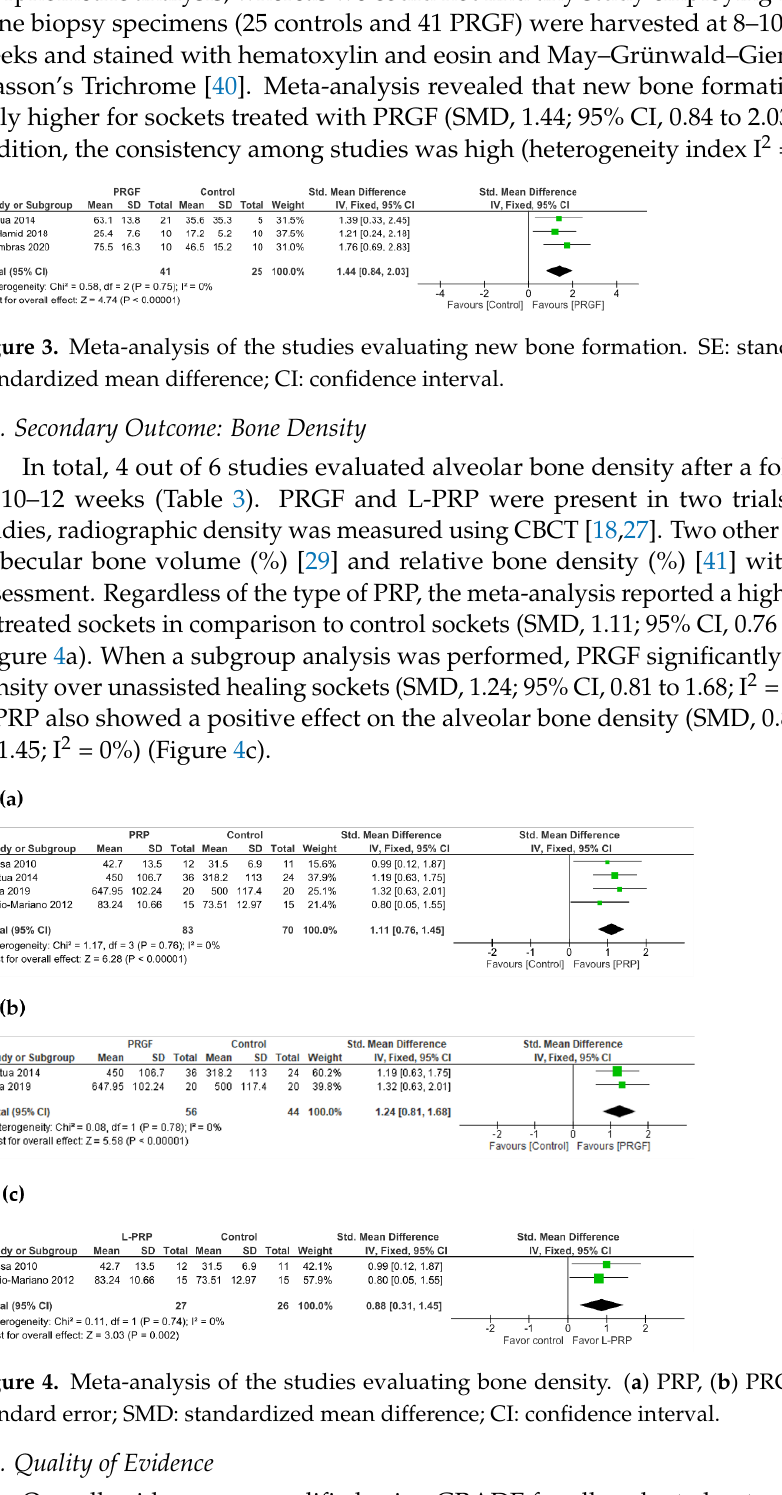
Figure 2. Study selection flow diagram. PRISMA flow diagram of the screening and selection pro- cess. Quality assessment of the included RCTs. ( a ) Risk of bias summary: review authors’ judgments about each risk of bias item for each included study: (+), low risk of bias; (?): unclear risk of bias. ( b ) Risk of bias graph: review authors’ judgments about each risk of bias item presented as percentage s across all included studies.